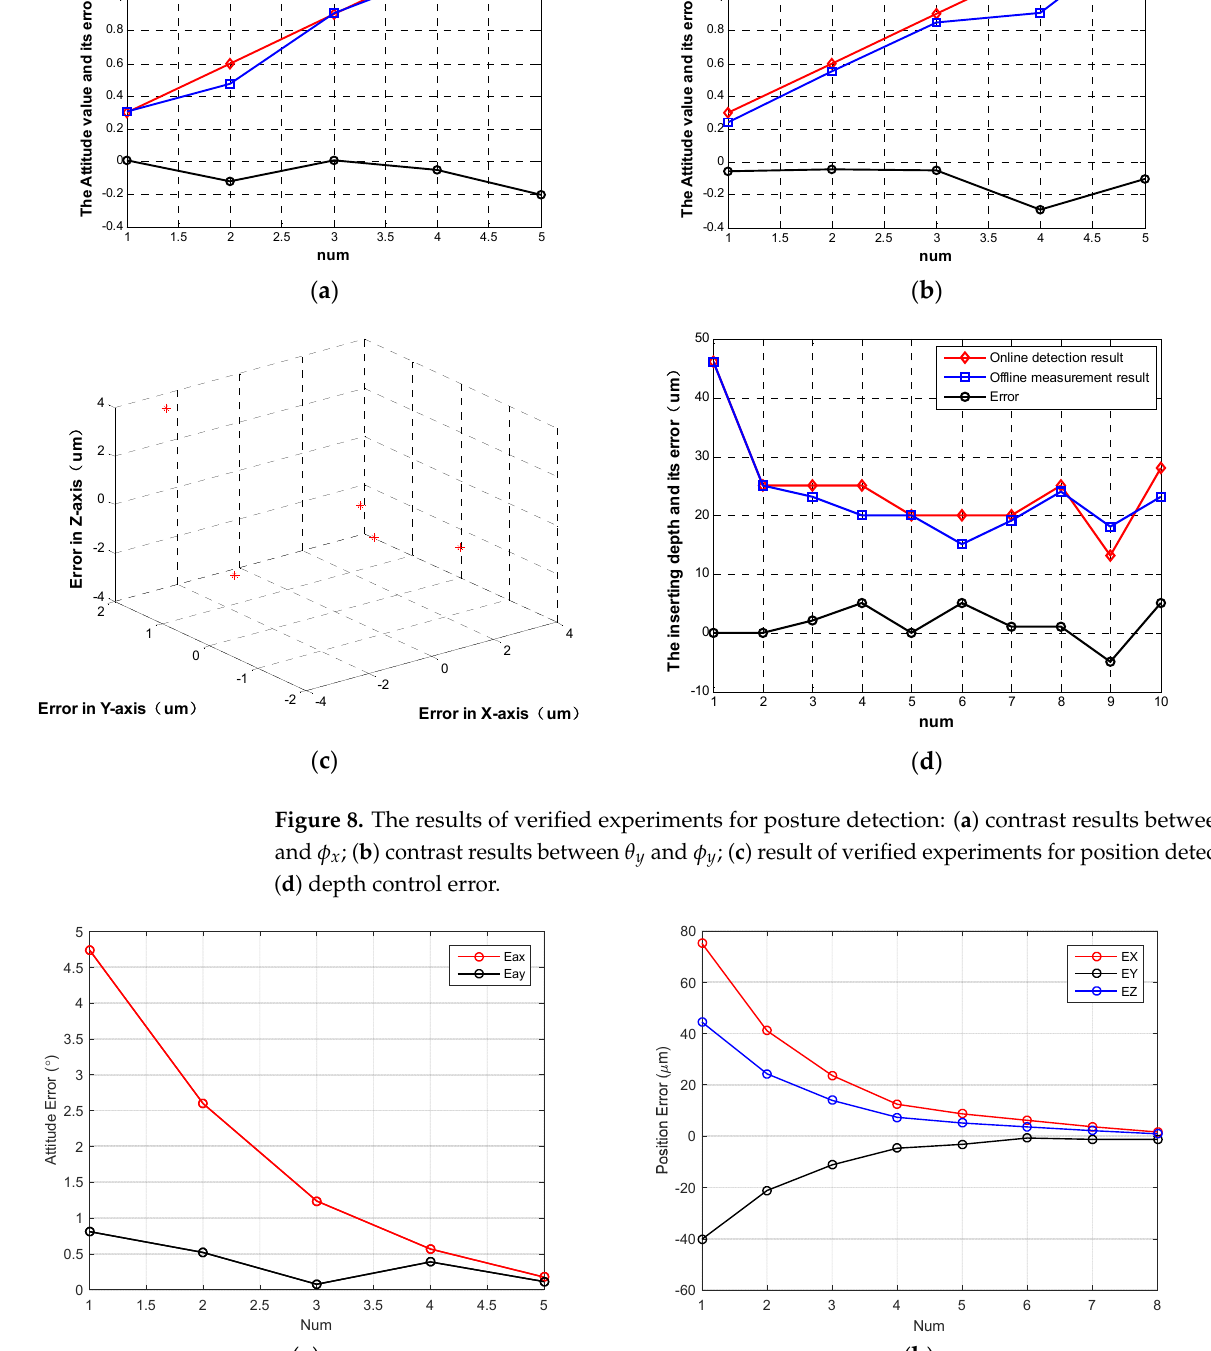
( b ) Figure 10. Image of attitude fine alignment: ( a ) images before attitude alignment; ( b ) images after attitude alignment. 4.1.2. Position Fine Alignment The position error analysis is similar to the attitude error analysis. By calculating the difference between the real position increment and the detection position increment in Cartesian space, the position detection error is calculated. As shown in Figure 8c, the de- tection error along the X-axis, Y-axis, and Z-axis are all less than ±4 µm based on 5-group experiment analysis. Micro-tube position is also adjusted by P controller. Figure 9b shows the position control error in the alignment process. The P coefficient is set to 0.5, and the control thresh- olds around the X- and Y-axis are both set to 5 µm. Figure 11 shows images before and after alignment, the micro-tube end feature is extracted to calculate position error. ( a ) ( b ) Figure 11. Image of position fine alignment: ( a ) images before alignment; ( b ) images after align- ment.